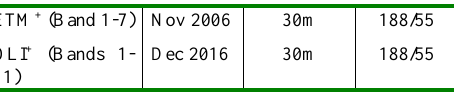
Table 1. Characteristics of Landsat images used